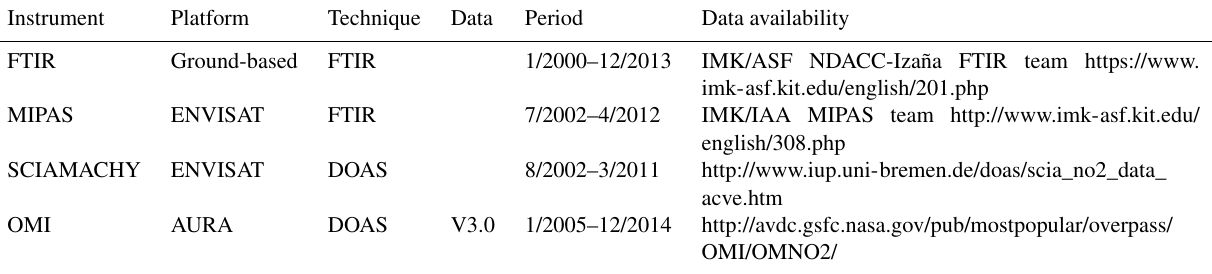
Table 4. Instrument